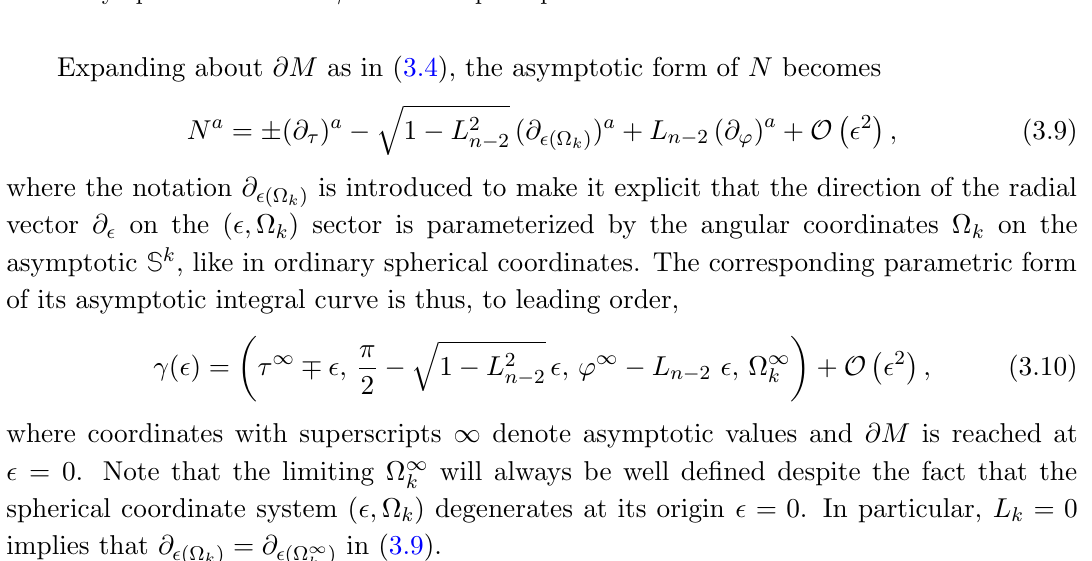
Figure 3 . Illustration of the tangent space normal to the conformal boundary at some r The vertical line represents the conformal boundary @M , and the normal plane corresponds to the radial and S k bulk dimensions. A null geodesic (cid:13) reaches @M with future-directed tangent vector N . The unit-norm orthogonal projection of this vector ^ N ? gives a point on S k which corresponds to the asymptotic location of (cid:13) on the compact